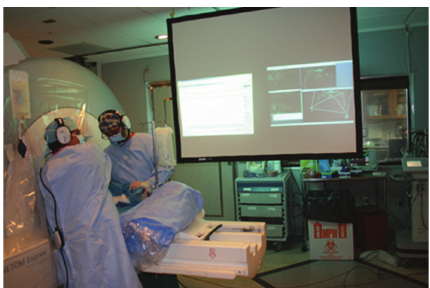
Figure 3: Using real-time MRI as projected onto the screen, the surgeon advances the delivery device into the LV. He can then precisely position the prosthetic valve for